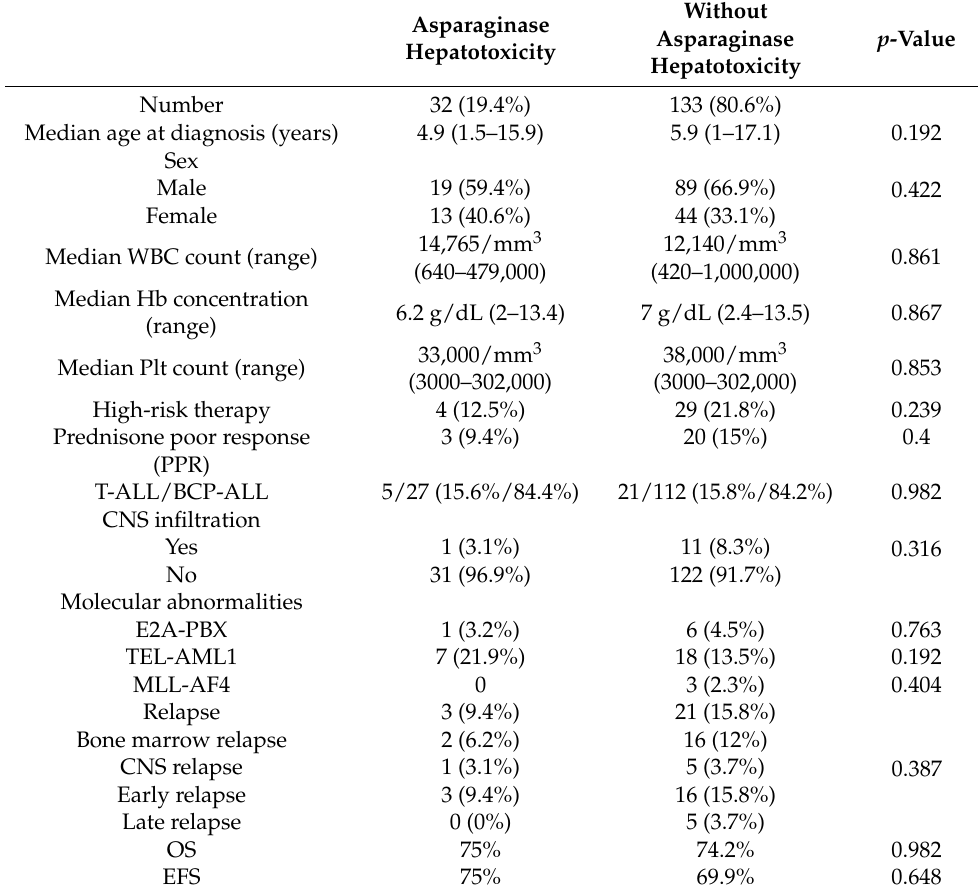
Table 6. Biological features and outcomes of patients with and without L-asparaginase